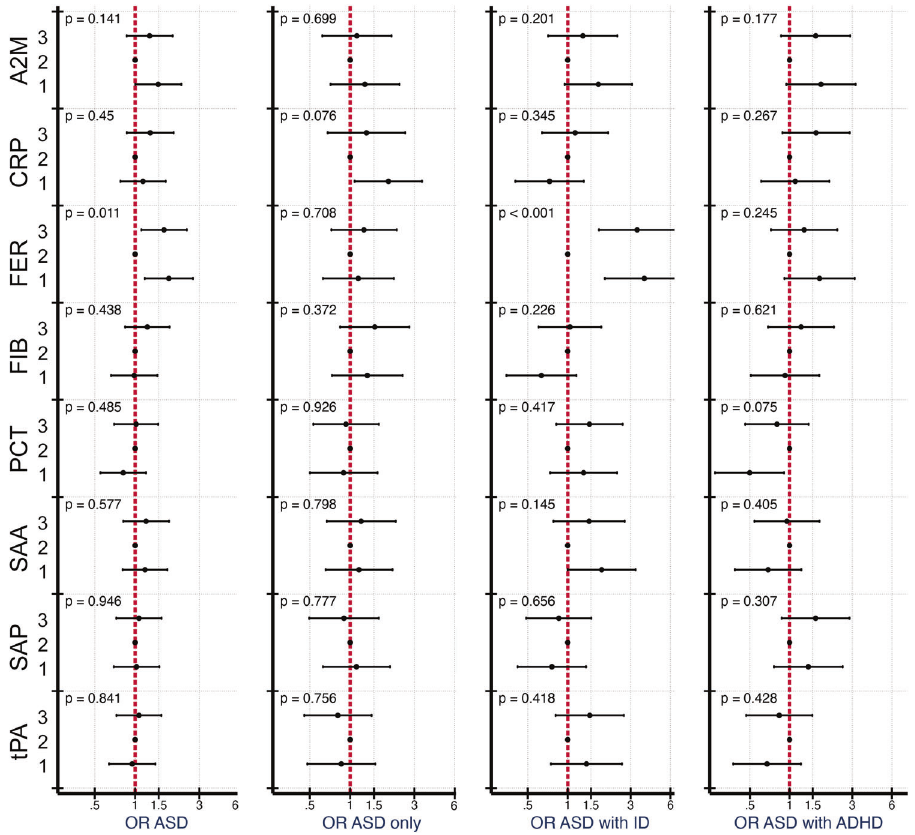
Fig. 2 The relationship between maternal APP measured prenatally and odds of ASD, strati fi ed by co-occurrence of ID and ADHD, when comparing mothers of 318 ASD cases to mothers of 429 unaffected individuals selected from the cohort. Tertiles of each APP were created using the distribution of z-scores among unaffected individuals to set the cut-offs, and the middle quintile was used as the referent category. Models were adjusted for sex, birth order, maternal BMI, maternal psychiatric history, maternal region of origin, maternal age and family income quintile. Error bars represent the 95% con fi dence interval for the fully adjusted model. P values are shown for a Wald test with a null hypothesis that all APP categorical terms were jointly equal to zero, as a test of whether each APP was generally associated with the outcome. Abbreviations: A2M α -2 macroglobulin, CRP C-reactive protein, FER ferritin, FIB fi brinogen, PCT procalcitonin, SAA serum amyloid A, SAP serum amyloid P, tPA tissue plasminogen